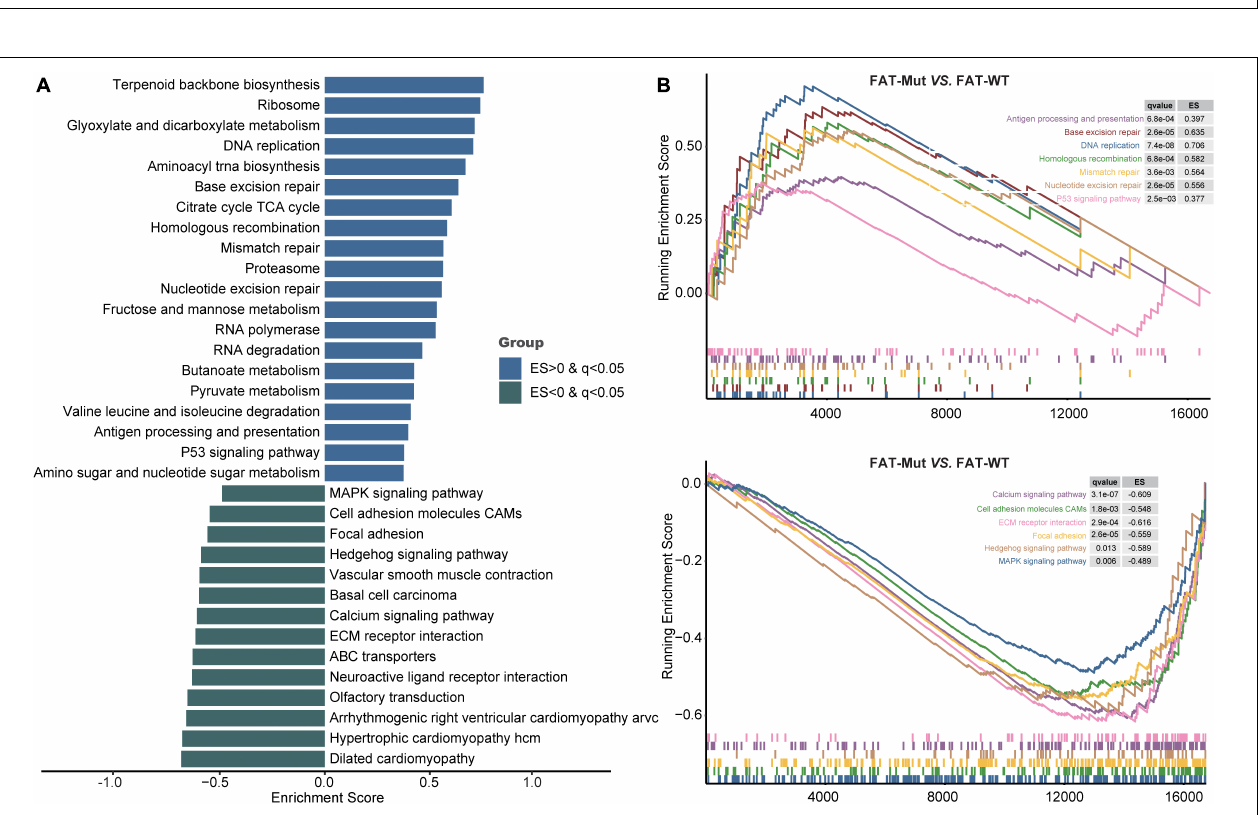
FIGURE 6 | Transcriptomic analysis based on FAT status. (A) KEGG gene sets downloaded from the MSigDB, and GSEA was used to enrich pathways. Enrichment pathways with significant differences between FAT-Mut and FAT-WT groups are shown. The blue bar means ES is greater than 0; the green bar means ES is less than 0. MSigDB, Molecular Signatures Database; GSEA, gene set enrichment analysis; and ES, enrichment score. (B) Enrichment plots from GSEA. The pathways that are differentially enriched in FAT-Mut patients are shown at the top, and the pathways that are differentially enriched in FAT-WT patients are shown at the bottom.